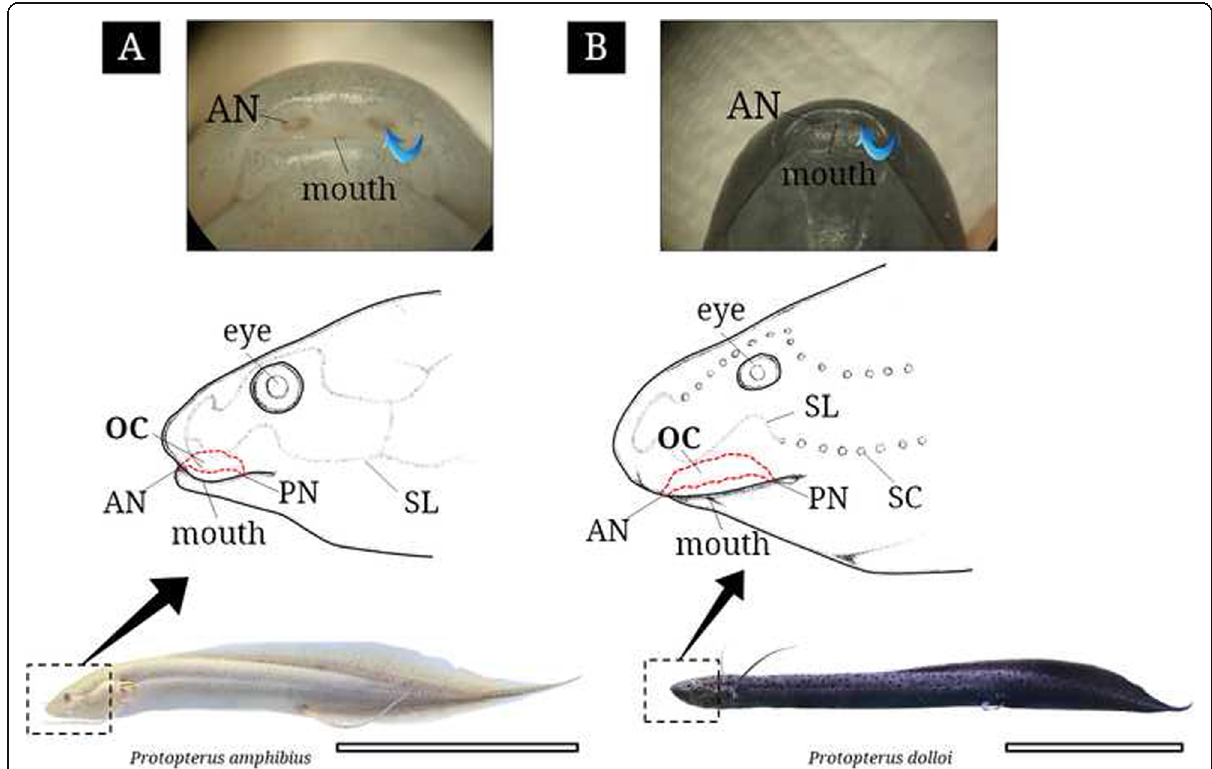
Fig. 1 External morphology of the olfactory organ in two lungfishes, Protopterus amphibius and P. dolloi . Blue bent lines indicate incurrent water flowing. Red broken lines indicate the olfactory chamber. AN, anterior nostril; OC, olfactory chamber; PN, posterior nostril; SC, sensory canal; SL, sensory line. The bars indicate 8